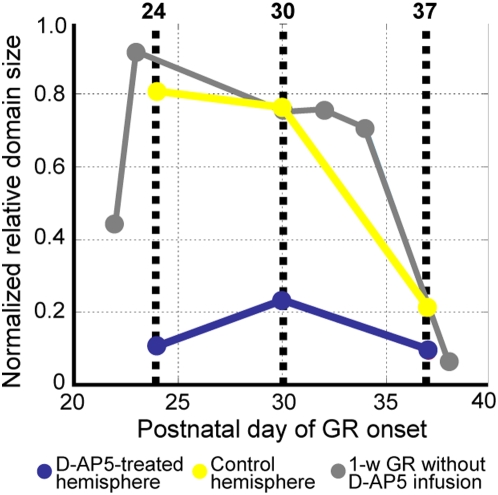
Effects of D-AP5 infusion on the sensitivity profile.Sensitivity profiles are shown for control and D-AP5-treated hemispheres, separately. For reference, we plot the sensitivity profile for 1-week GR without D-AP5 infusion obtained from 6 kittens. Symbols are defined in the figure.